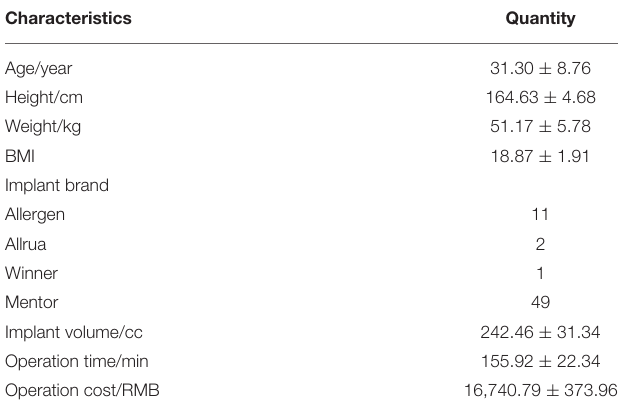
TABLE 1 | Patient demographic characteristics. TABLE 2 | Transaxillary endoscopic biplane breast augmentation complications